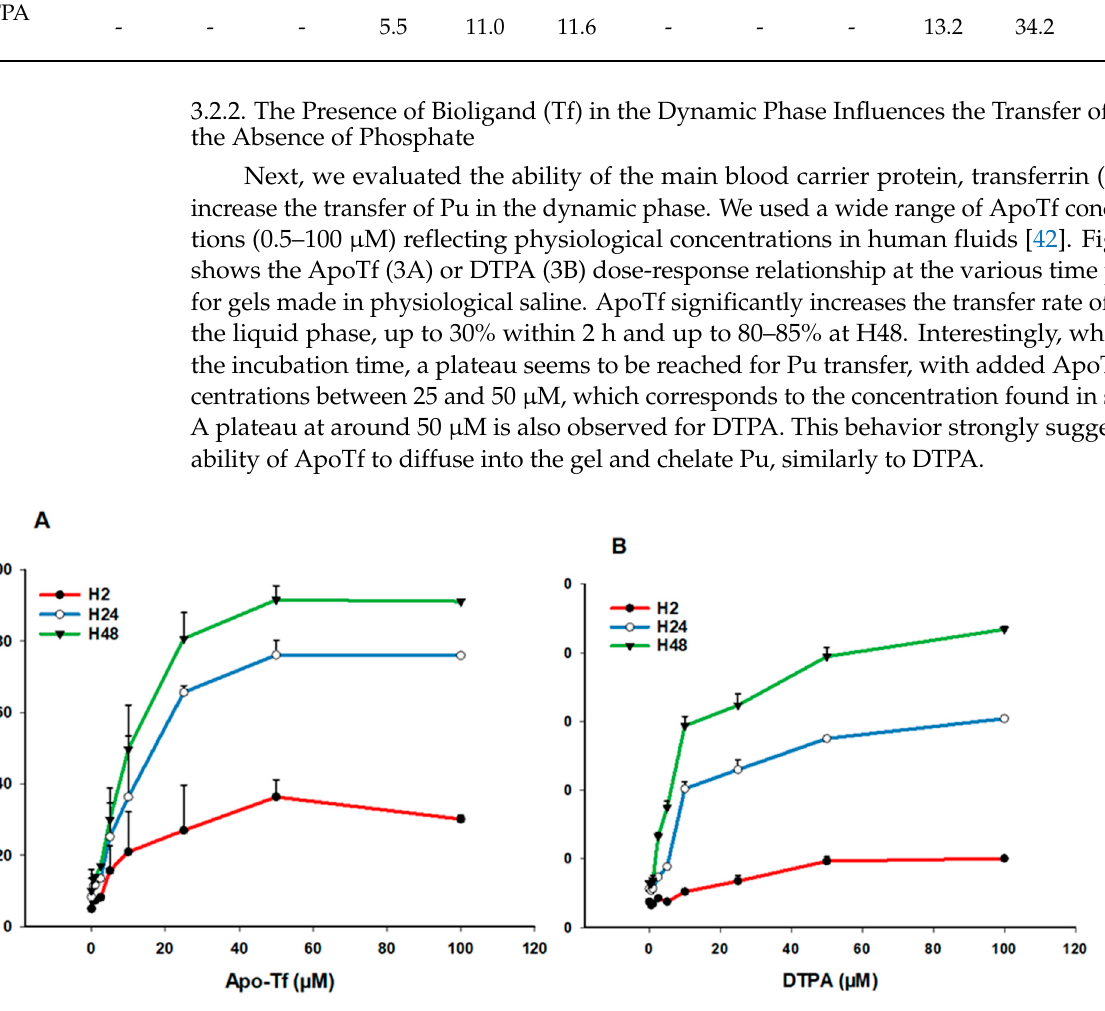
Figure 3. Transfer of Pu in simple saline solution in the presence of ApoTf or DTPA. Pu was included in the static retention phase (agarose gels) prepared in NaCl/KCl. After 2, 24, and 48 h incubation in NaCl/KCl supplemented with increasing concentrations of ApoTf ( A ) or DTPA ( B ), the transferred activity was measured in the dynamic phase using liquid scintillation counting. Results are ex- pressed as cumulative activity/initial activity in the gel at the various times, according to ApoTf or DTPA concentrations. Each experimental condition was done in triplicate and experiments were repeated once for DTPA and twice for ApoTf.